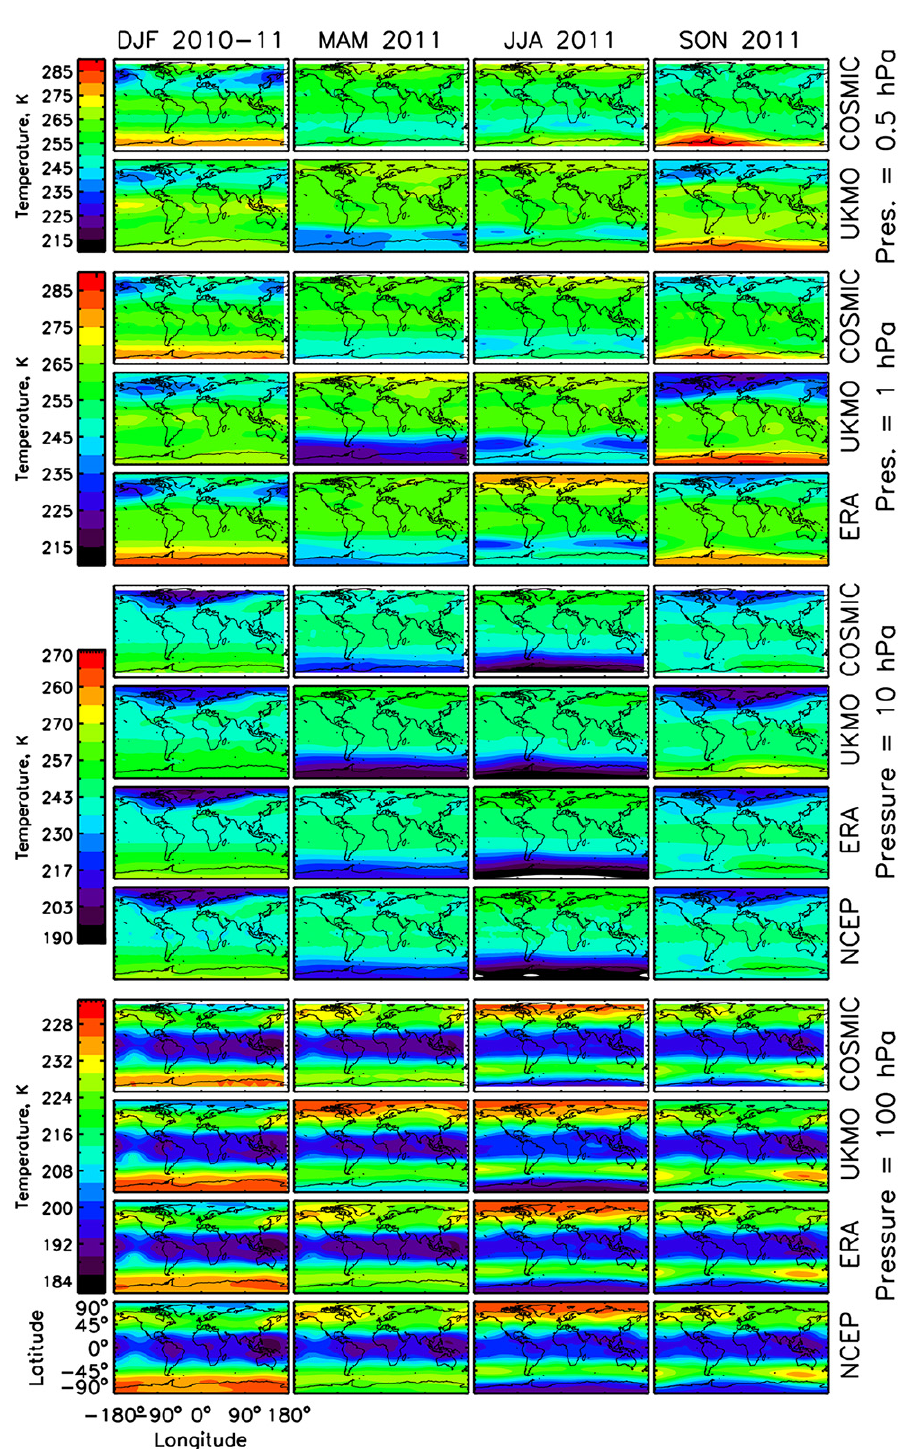
Fig. 4. Global seasonal means of COSMIC temperatures and the various reanalysis outputs – NCEP, ERA-Interim, and UKMO, at the pressure levels 100hPa (rows 1 to 4 from bottom), 10hPa (rows 5 to 8 from bottom), 1hPa (rows 3 to 5 from above) and 0.5hPa (rows 1 & 2 from